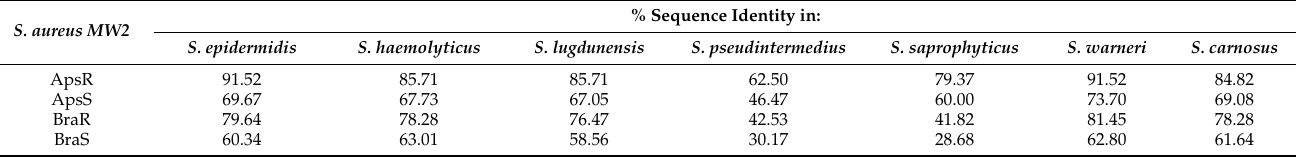
Table 2. % amino acid sequence identity of ApsRS and BraRS in S. aureus compared to eight Staphylococcal species. S. aureus